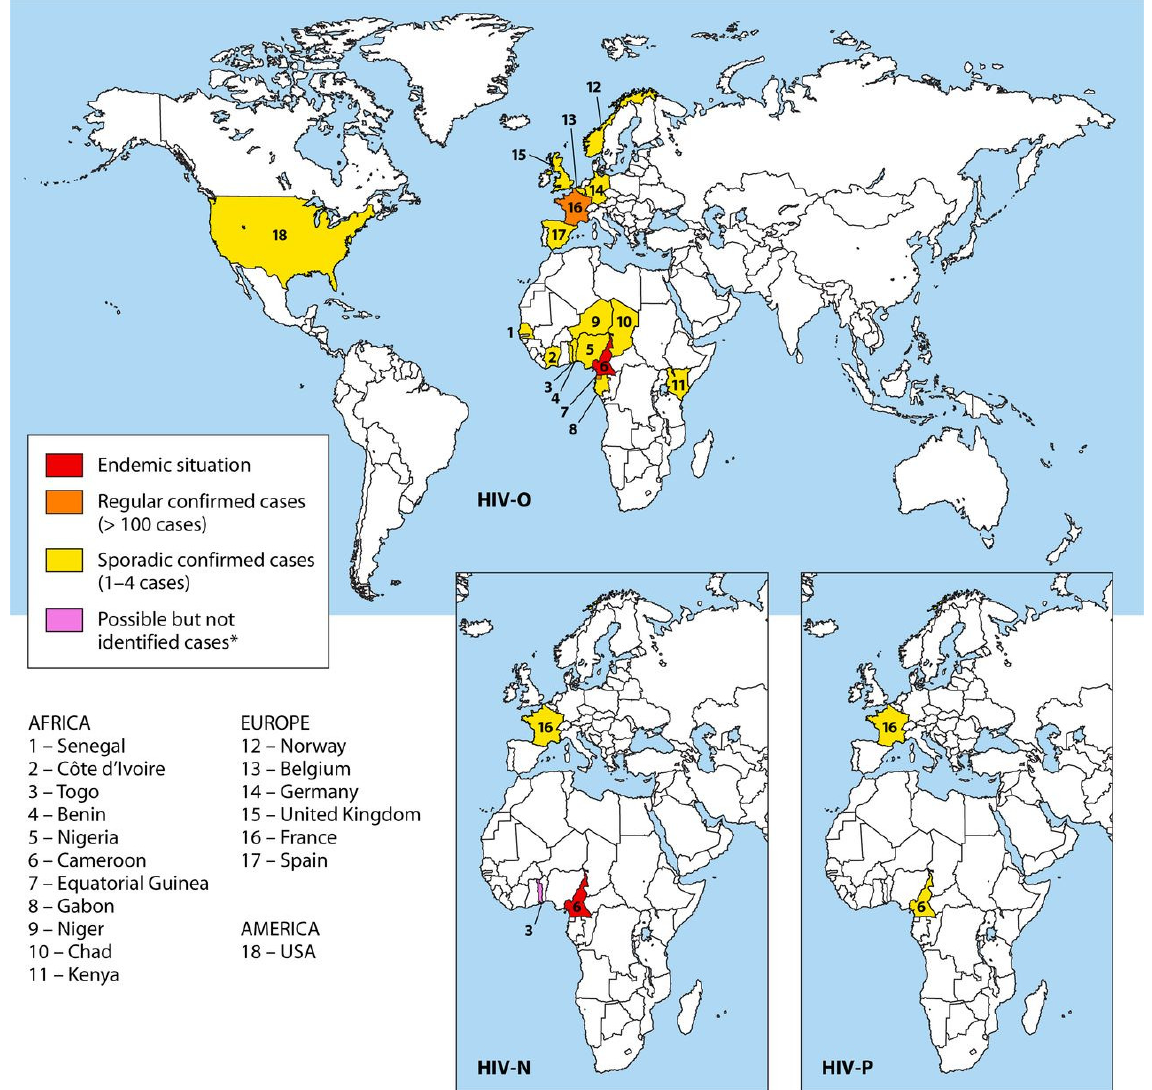
Figure 2. Molecular epidemiology of HIV-1 non-group M. The three maps represent the worldwide distribution of the HIV-1/O, HIV-1/N and HIV-1/P variants, reprinted from [22]. * One case of group N infection was detected in France but has likely its origin in Togo [23].